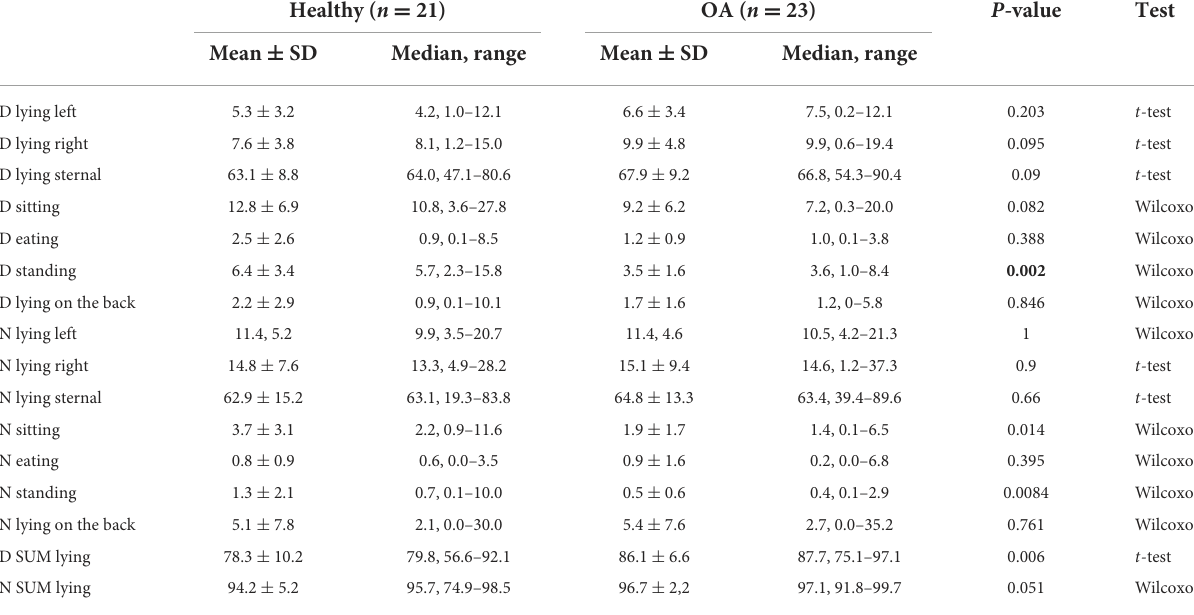
TABLE 5 Mean time spent in each position (expressed as a percentage of the total time a position was recorded by PetPace) for daytime and nighttime periods.